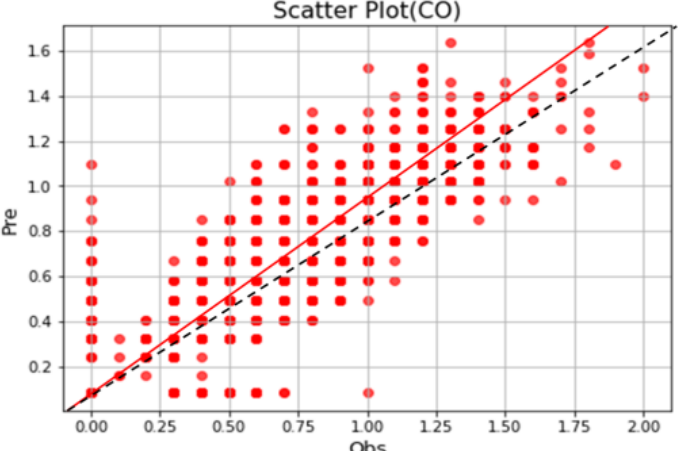
Figure 12. Comparison results of predicted carbon monoxide with observations. The regression line of observed and predicted data is indicated in red.